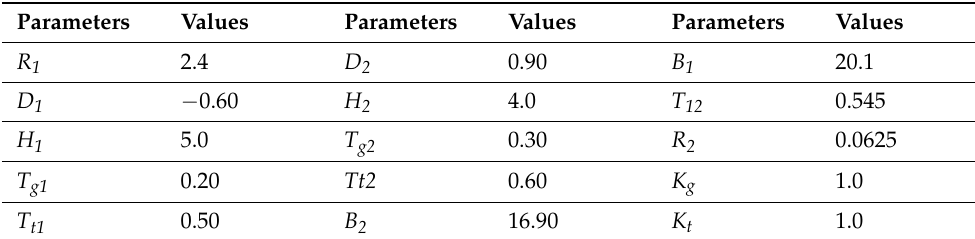
Table 1. Studied power system